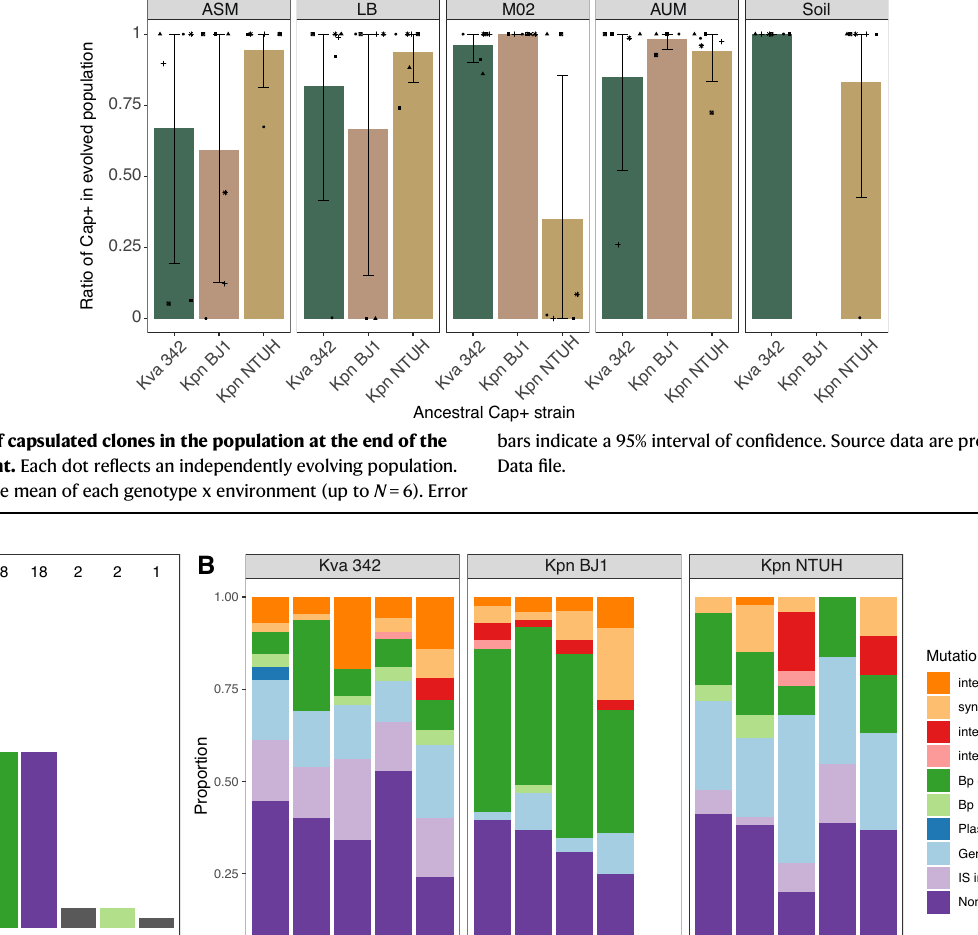
nucleotide polymorphisms, complex combination of two mechanisms. bp base pair. B Type of mutations observed in the 164 clones of the long evolution experiment after ~675 generations (end-point). Source data are provided as a Source Data fi